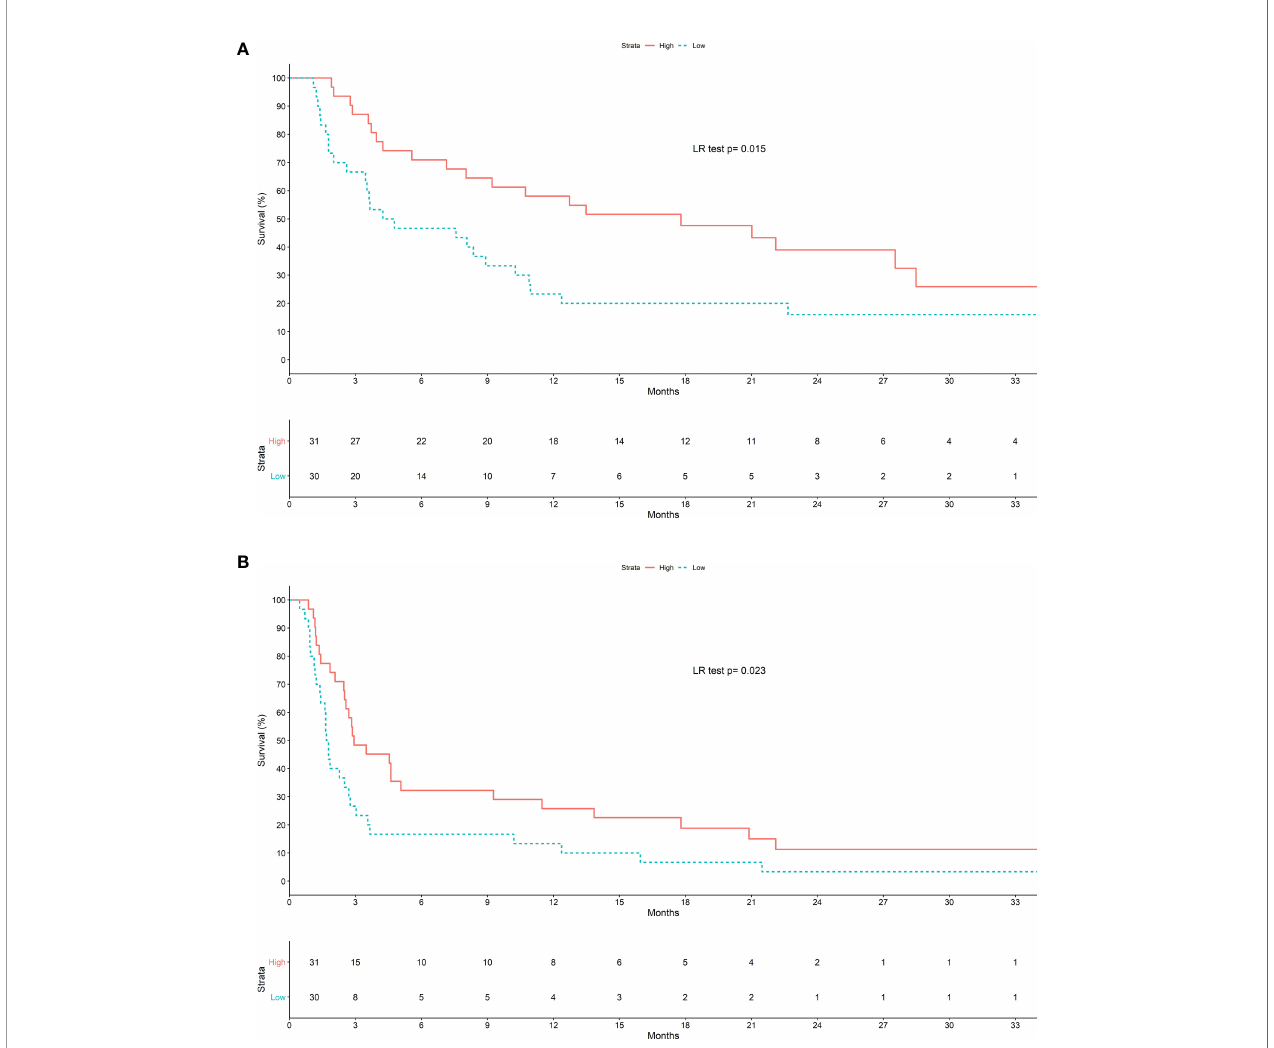
FIGURE 1 | Kaplan-Meier survival curves according to baseline SMI. (A) Overall survival. (B) Progression Free